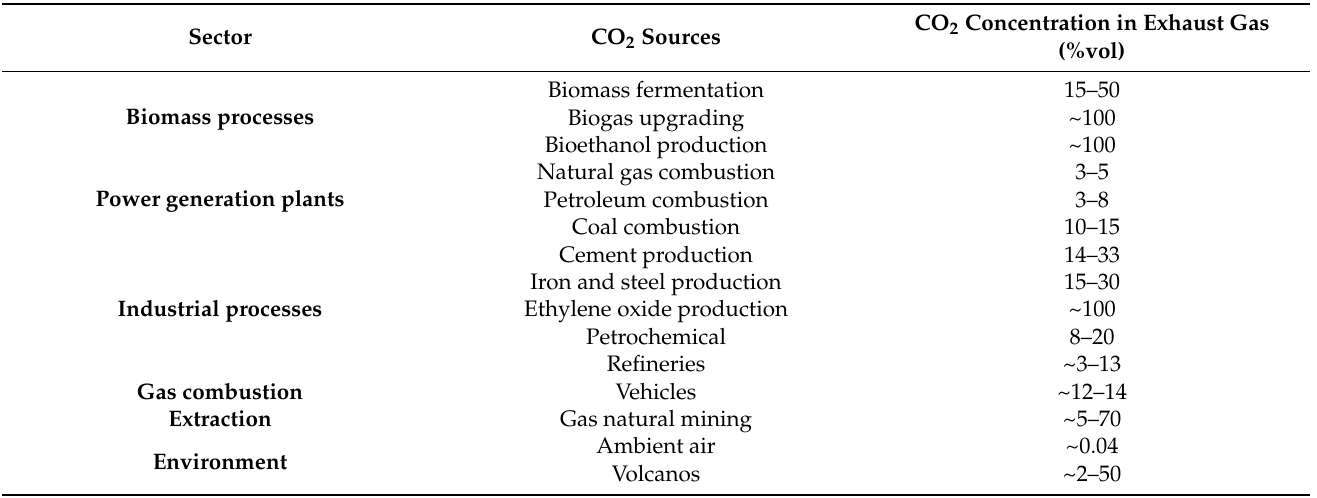
Table 8. Main sources of CO 2 . Data reproduced with permission from Karim Ghaib, Fatima-Zahrae Ben-Fares, Renewable and Sustainable Energy Reviews; published by Elsevier, 2018 [110]; and Hasmukh A Patel, Jeehye Byun, Cafer T Yavuz, ChemSusChem, published by John Wiley and Sons, 2017